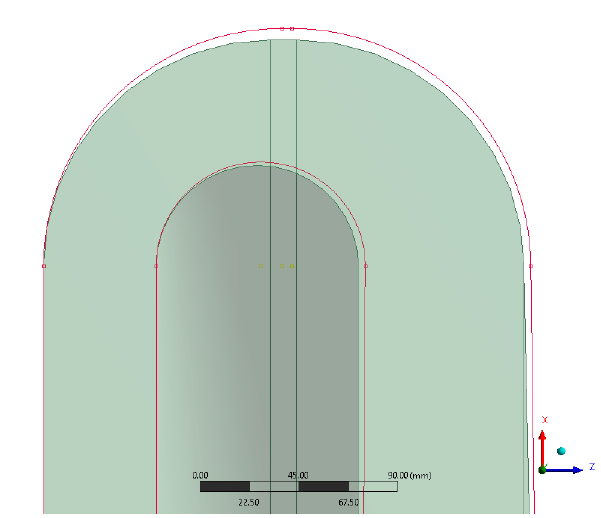
Figure 19. U-bend according to the preliminary design ( gray ) and after optimization ( red ).